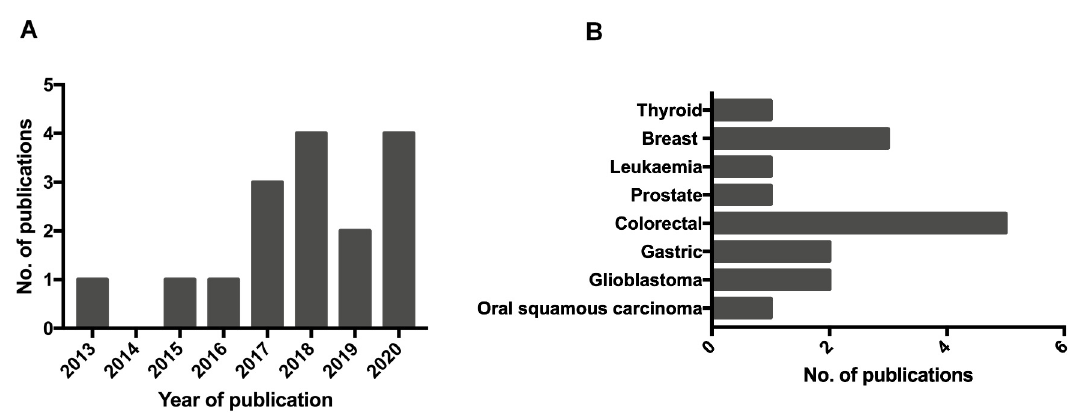
Figure 3. Distribution of eligible publications by year and cancer type. ( A ) Eligible studies were published between 2013 and 2020, with the largest proportions contributed between 2017 and 2020. ( B ) The representation of cancer types per eligible study, demonstrating a prevalence of studies in the colorectal and breast cancer fields.